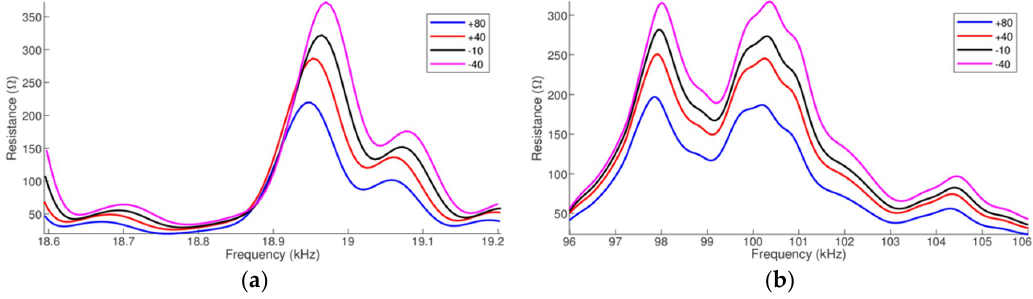
Figure 6. Vertical shift of the impedan ces (real part) pipe-1/PZT-1: ( a ) at low frequency and ( b ) at high frequency.